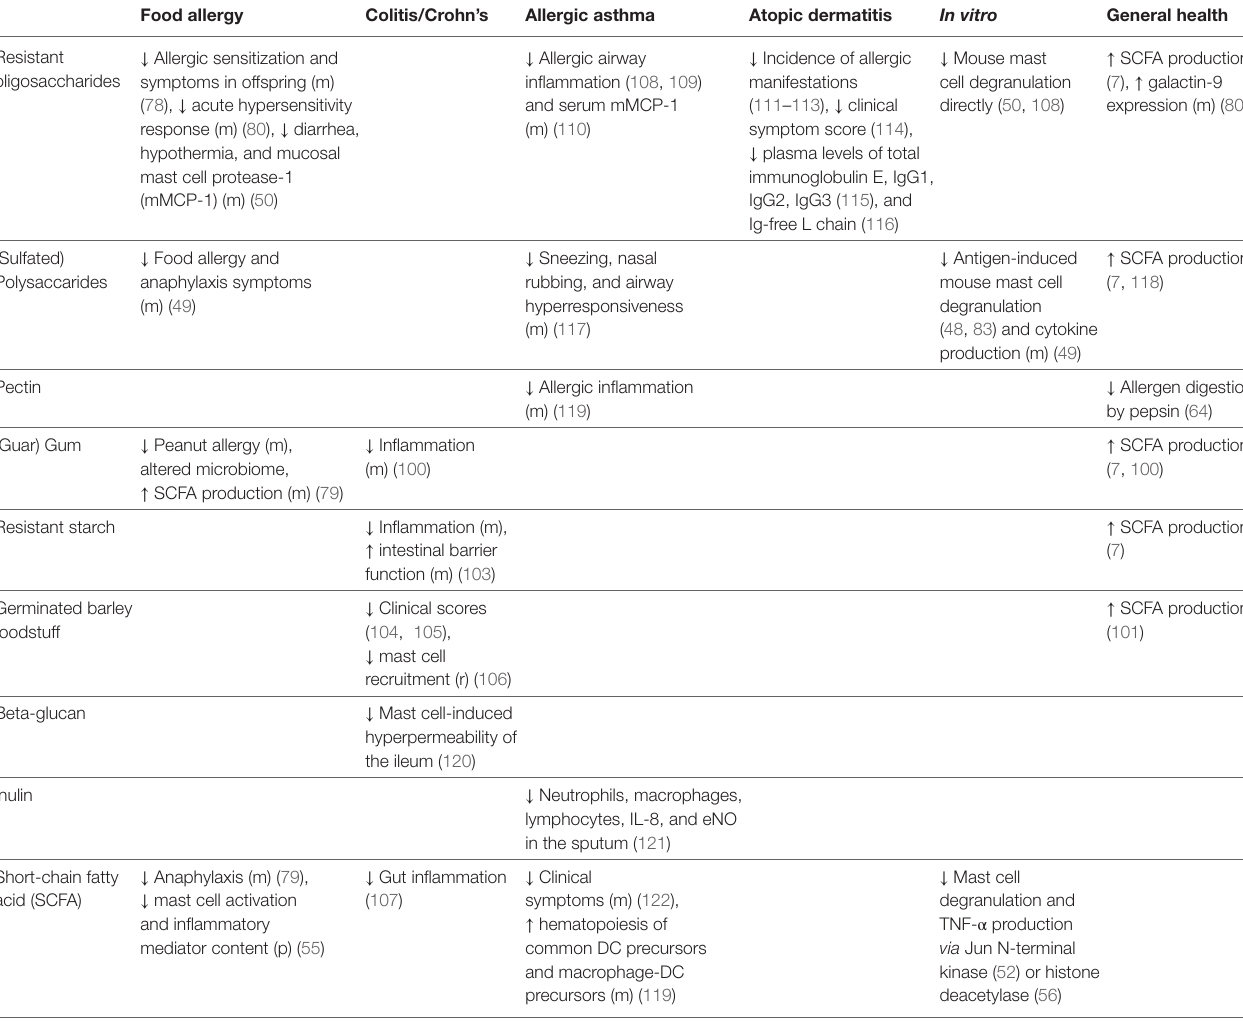
TAble 2 | Dietary fiber and metabolites in mast cell-associated diseases. Food allergy Colitis/Crohn’s Allergic